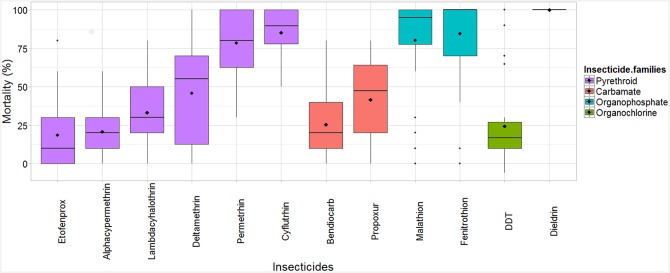
Box-and-whisker plot of mortality rate after 24 hours for each in secticide for all populations study sites.Black Diamond-shaped points inside the boxes are mean values. Horizontal bars in boxes are the 50th percentiles (medians), and the bottom and the top of the box represent the 25th and the 75th percentiles, respectively. The two limits of vertical lines above and at the bottom of the box are the wiskers and represent the maximum and the minimum values of the data. Points outside the limit of vertical line are “outlier”, which are values outside 95% the confidence interval.